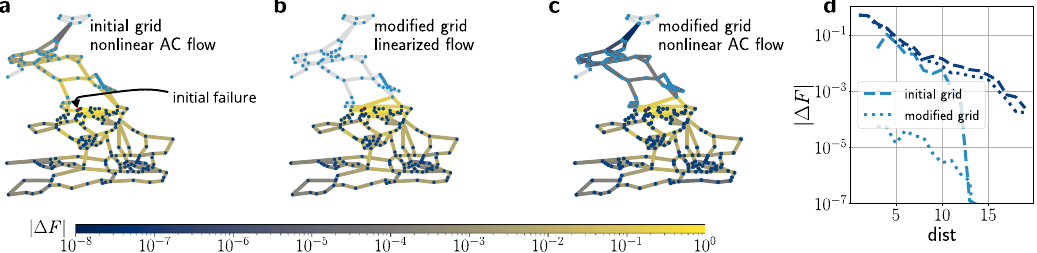
Fig. 6 Network isolators suppress failure spreading in full non-linear AC load fl ow. a An initially failing link with unit fl ow (red) in the British power grid results in changes of real power fl ow (colour code) throughout the whole network, as obtained by computing a non-linear full AC power fl ow 44 . b , c After introducing a network isolator based on the strategy presented in panel ( a of Fig. 3), failure spreading is perfectly inhibited in the linear power fl ow approximation, and still signi fi cantly reduced in the non-linear full AC load fl ow. d We compare the median absolute fl ow changes, calculated using the non-linear load fl ow (Eq. (12)), after the failure of the link in the initial grid (dashed lines, a ) and the modi fi ed grid (dotted lines, c ). Whereas the fl ow changes in the lower module of the power grid (dark blue nodes) stay approximately the same after the grid modi fi cation (dark blue lines), they are signi fi cantly reduced in the grid ’ s upper module (light blue nodes) that is shielded by the network isolator (light blue